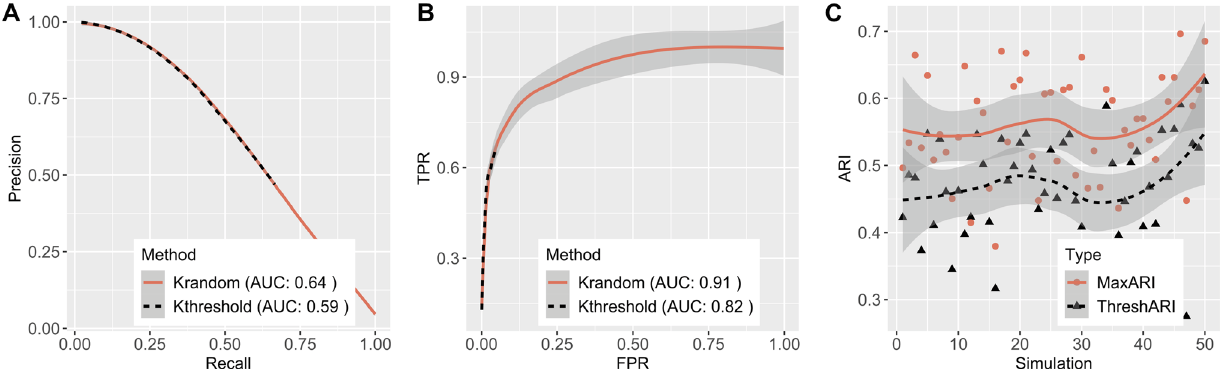
Fig. 6 Performance of GMM-based threshold strategy